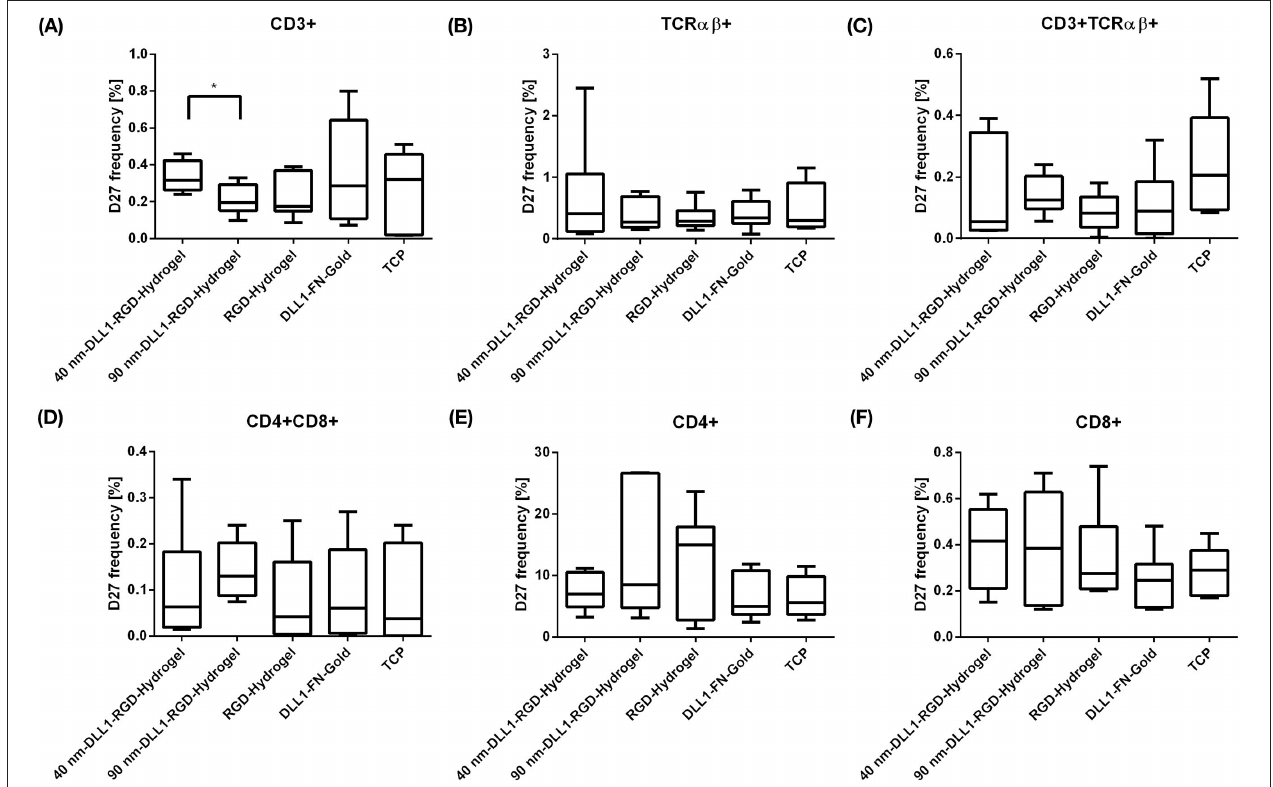
FIGURE 5 | Expression of cell surface markers indicating the stage of T cell differentiation from human UCB CD34 + cells. CD34 + cells were exposed to DLL1-nanostructured and pure RGD-PEGDA hydrogels as well as DLL1-non-structured fibronectin gold substrates in culture of 27 days. DLL1 nanopattern with interparticle spacings of ∼ 40 and 90nm were applied. Cultured cells were analyzed by flow cytometry for surface expression of late T cell markers CD3, TCR αβ , CD4, and CD8 as single positive (A,B,E,F) or double positive population (C,D) . Data presented as box plots showing the percentage of cells positive for the different markers. Data from N = 6 samples of each surface type from three independent experiments are shown. TCP, tissue culture plastic; FN, fibronectin. Significant differences are indicated by * P <